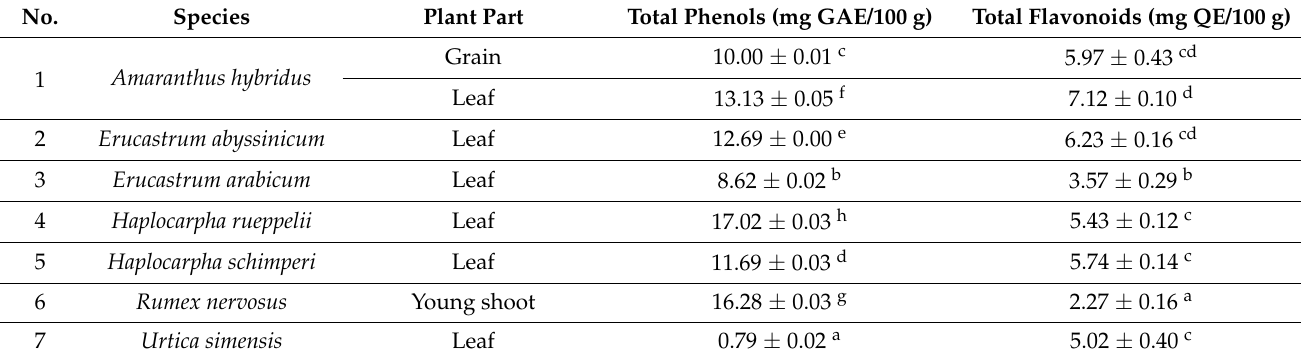
Table 1. Total phenolic and total flavonoid contents of selected wild edible